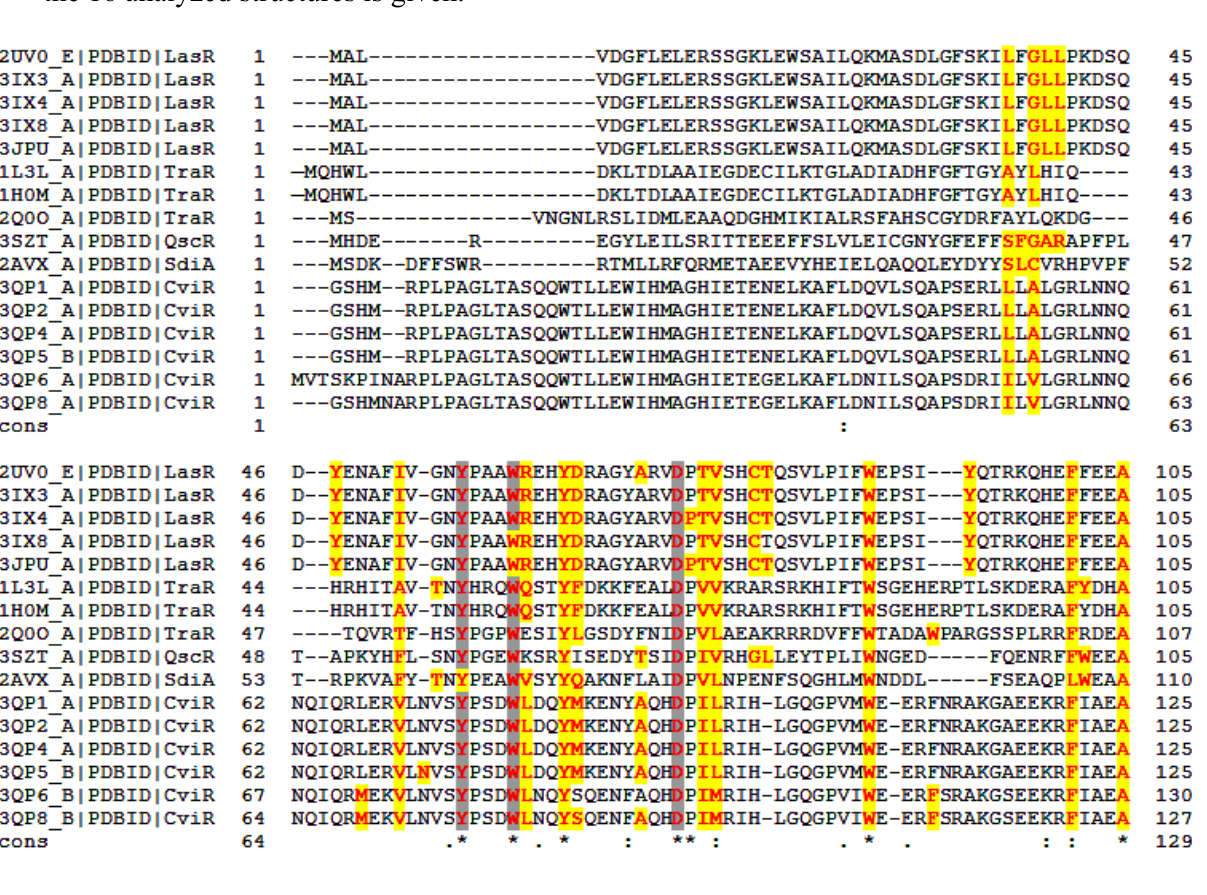
Figure 1. Structure-based multiple sequence alignment of the quorum sensing (QS) LuxRs whose structures have been solved to date. The residues directly involved in ligand binding are in bold and colored in red. The residues highlighted in yellow and in gray are engaged in hydrogen bonding and in hydrophobic interactions with the ligand, respectively. Stars highlight conserved positions; colon and period indicate respectively conservation between groups having strong or weak similarity. The unique identification PDB code (PDB_ID) of the 16 analyzed structures is